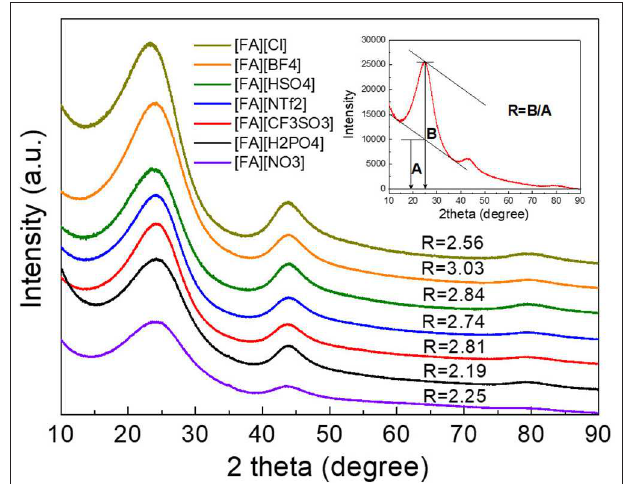
FIGURE 2 | XRD patterns of carbons derived from [FA][X]. The inset is a sketch map for the calculation of the R -values.